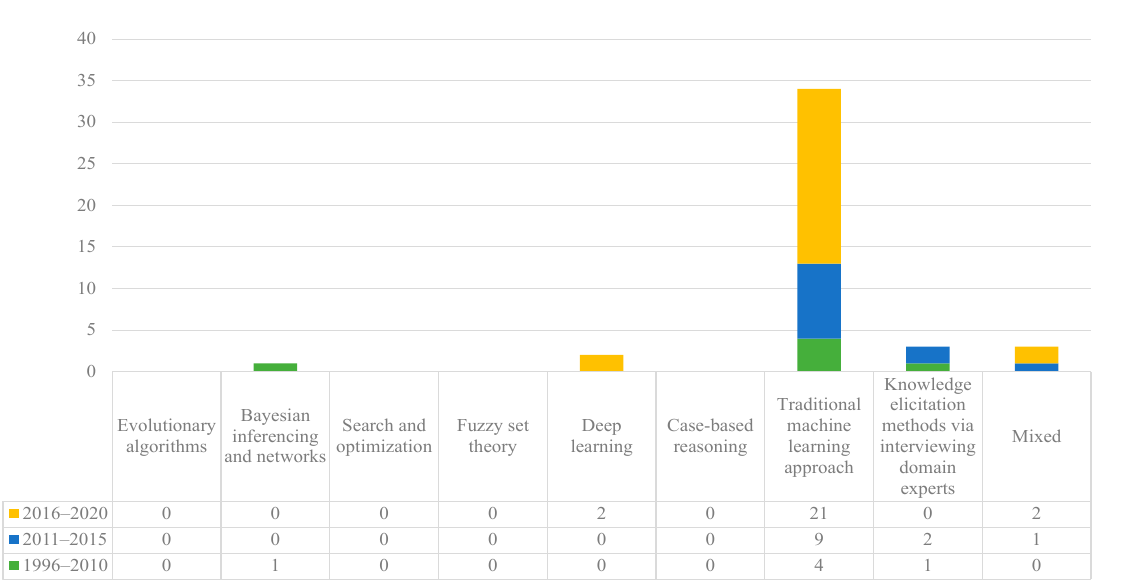
Figure 13. Adopted technologies of AIME research in each period.